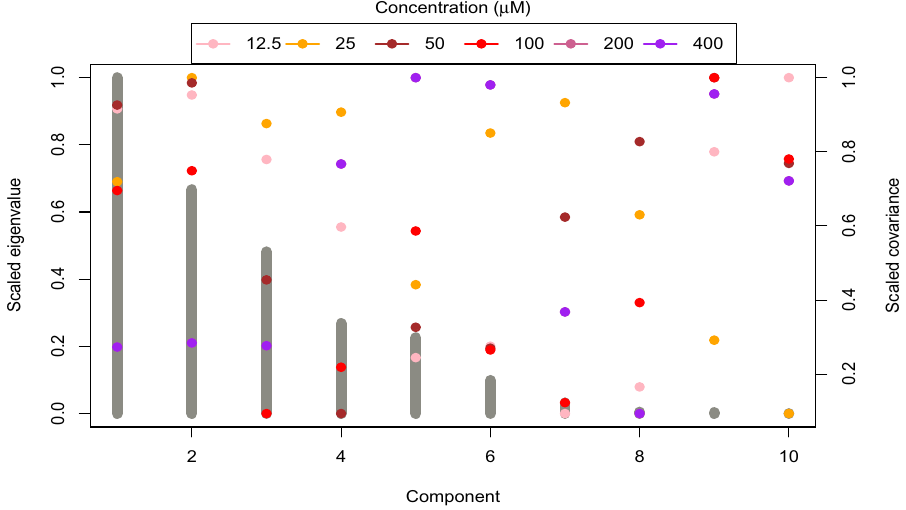
Figure 5. Data properties for the MTX derivative survival fraction as well as spectral data are provided. The bars represent the spectral eigenvalues of ionic fluids (scaled by the largest). The dots show the relationship between the main components and the survival fraction of MTX derivatives at different concentrations (scaled by the